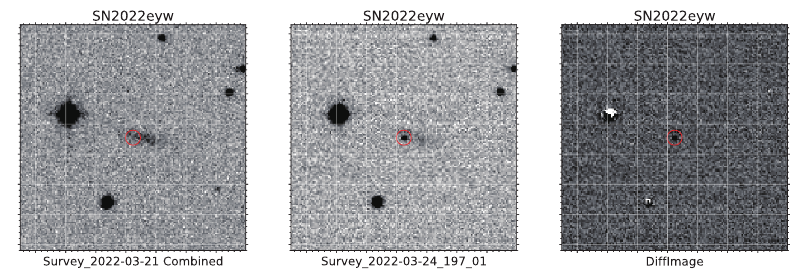
Figure 10. The right image is the combination image from 21 March 2022 at the position of SN 2022eyw with a magnitude limit of 19.26. The middle image is the first discovery image of the SN 2022eyw by AST3-3 on 24 March 2022. The right image is the difference image produced by the transient detection pipeline with SFFT